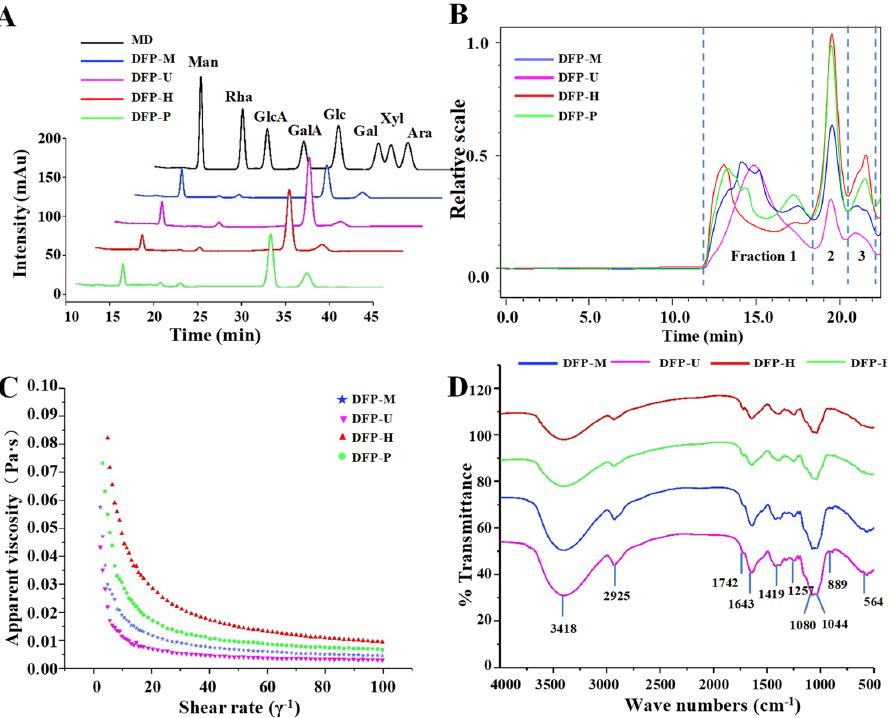
Figure 2. HPLC profiles ( A ); HPSEC chromatograms ( B ); apparent viscosities ( C ) and FT-IR spectra ( D ) of DFP-H, DFP-M, DFP-U, and DFP-P ( D. indusiata polysaccharides prepared by HWE, MAE, UAE, and PAE, respectively); MD, mixed standard of monosaccharides; Man, mannose; Rha, rhamnose; GlcA, glucuronic acid; GalA, galacturonic acid; Glc, glucose; Gal, galactose; Xyl, xylose; Ara, arabinose. mAu, the signal intensity of monosaccharides derivatized with PMP detected by diode array detector.